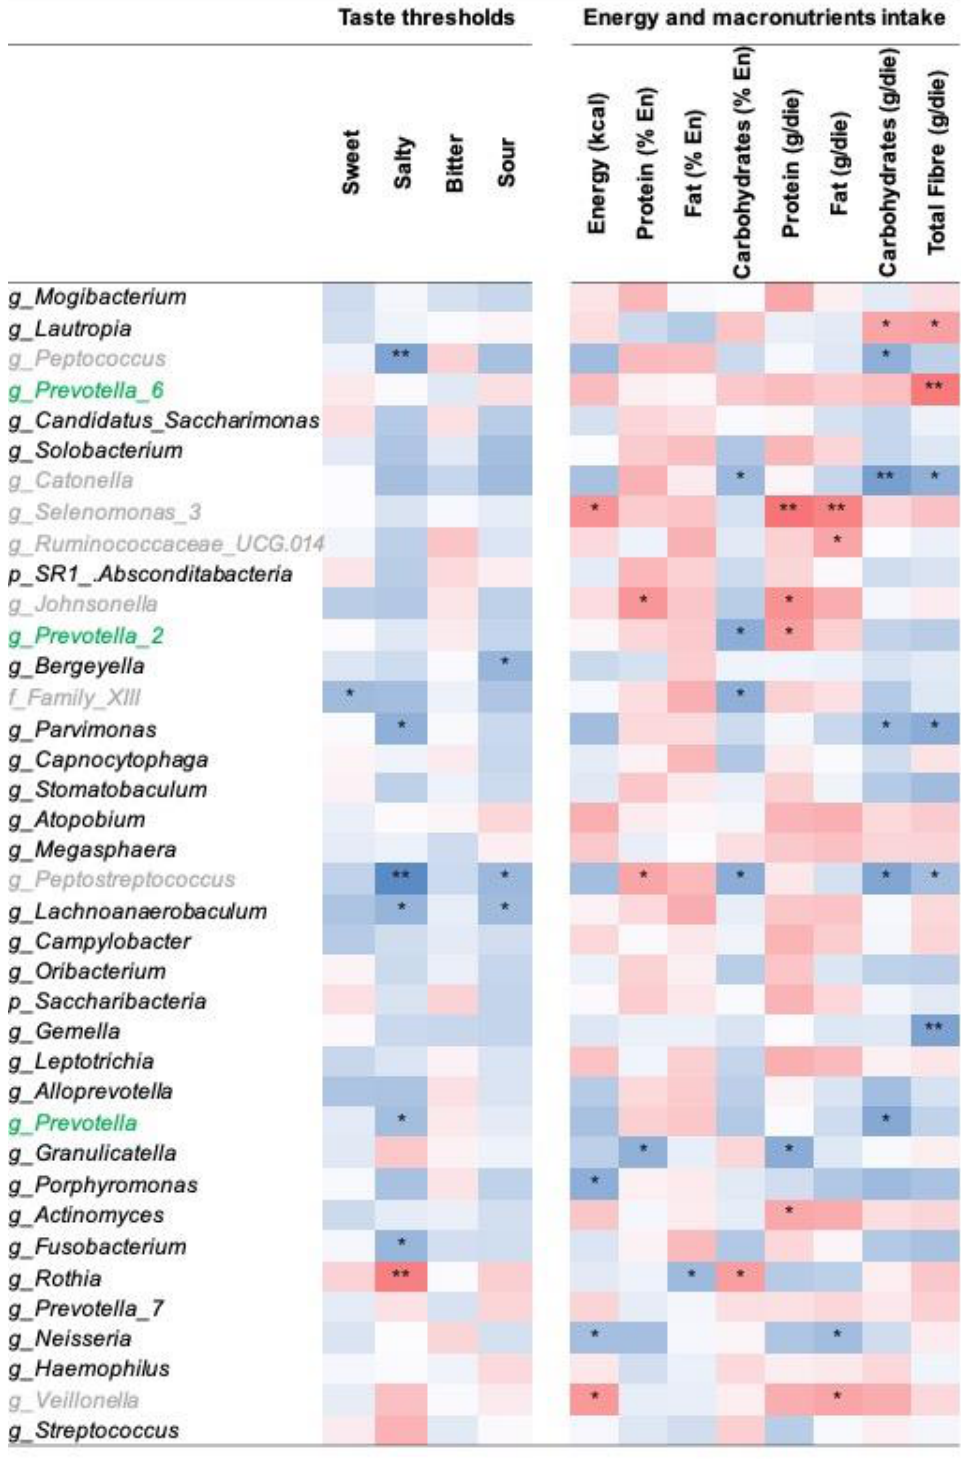
Figure 1. Correlations between the relative abundance of bacterial taxa on tongue dorsum and taste thresholds for the four basic tastes (left side) and nutritional variables (right side). The heatmap represents the Spearman’s correlation R-values. Asterisks relate to the Kendall rank correlation p values: * p < 0.05; ** p < 0.01. Prevotella genera and Clostridia class, which showed significant correlation with energy and macronutrients intake, are highlighted in green and in grey colors,